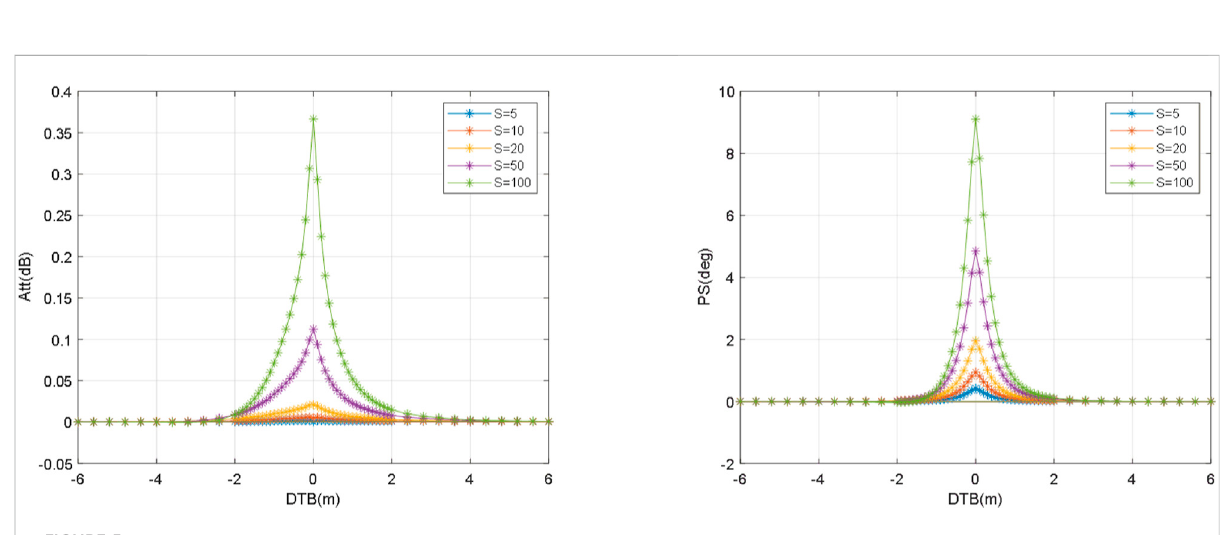
FIGURE 5 Response of the tilted receiver in different contrast stratum